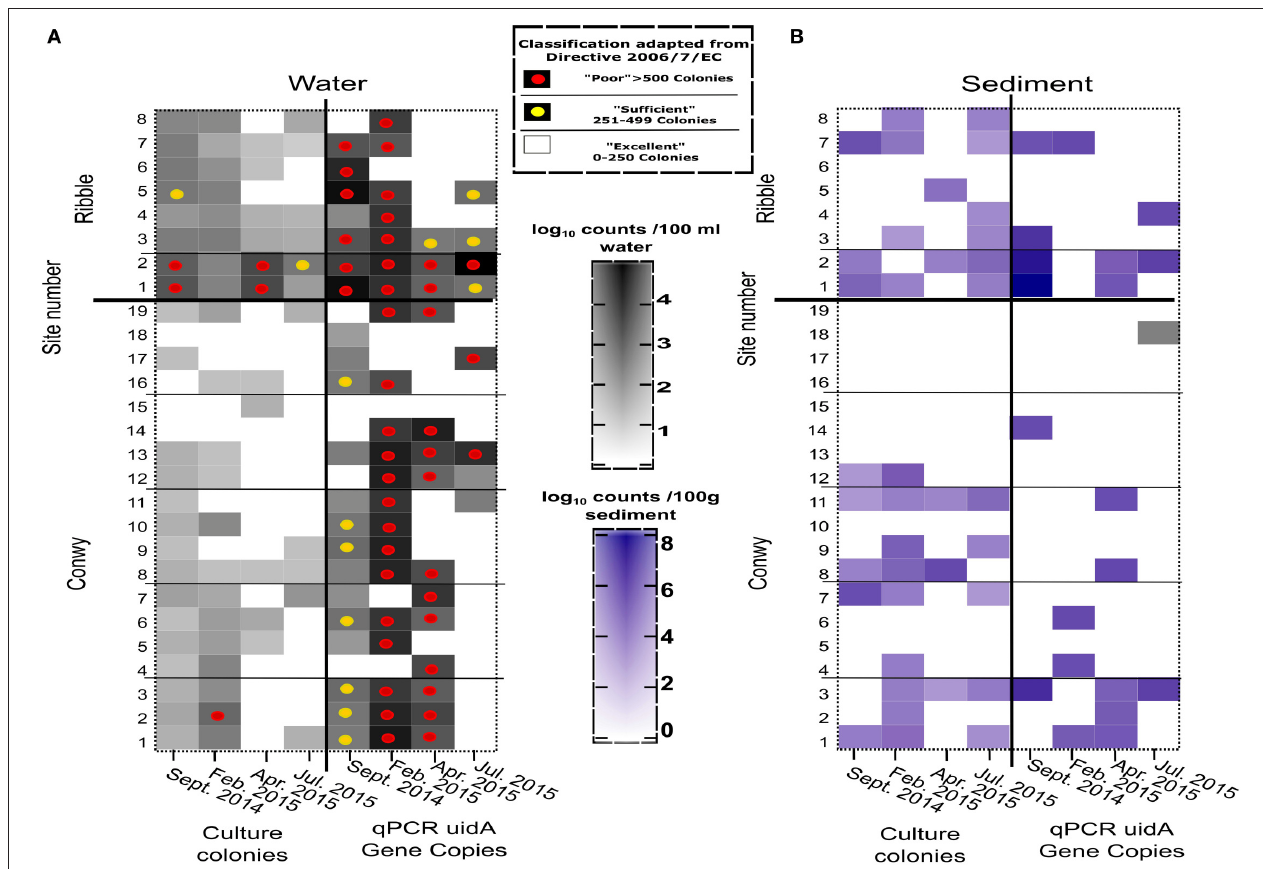
FIGURE 3 | E. coli abundance in the Conwy estuary (sites 1–19) and the Ribble estuary (sites 1–8) for sampling events (A) Water (CFU/100ml or GC/100ml), (B) Sediment (CFU/100 g or GC/100 g wet weight). Sample sites compliance indicated by superimposed circles for Water Framework Directive 2015 2006/7/EC for Water (see box). Samples without circle indicates better than “excellent” water quality for Coastal and Transitional